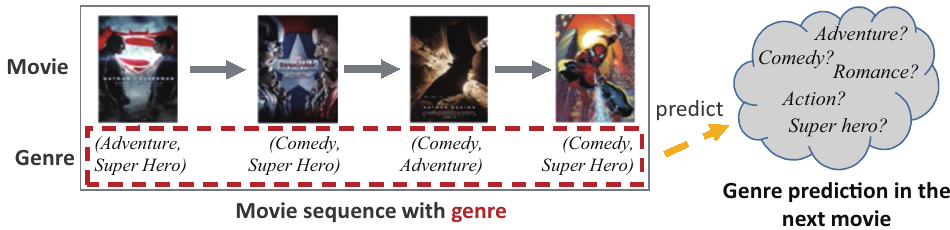
Figure 1. Movie genre prediction: Based on the genre included in the user’s movie sequence, we study a prediction on the next